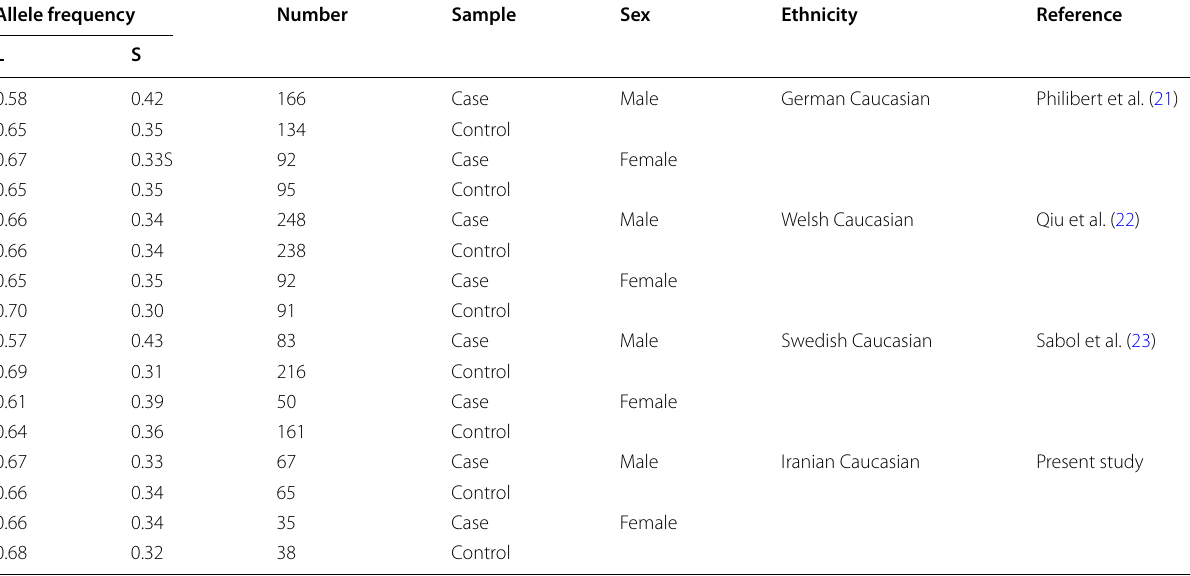
Table 3 Comparison of the MAOA uVNTR allelic frequencies in different ethnicities Allele